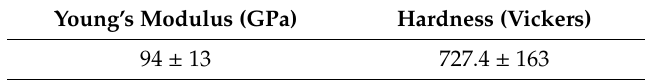
Table 3. Young’s modulus and hardness, as determined by micro-indentation tests.